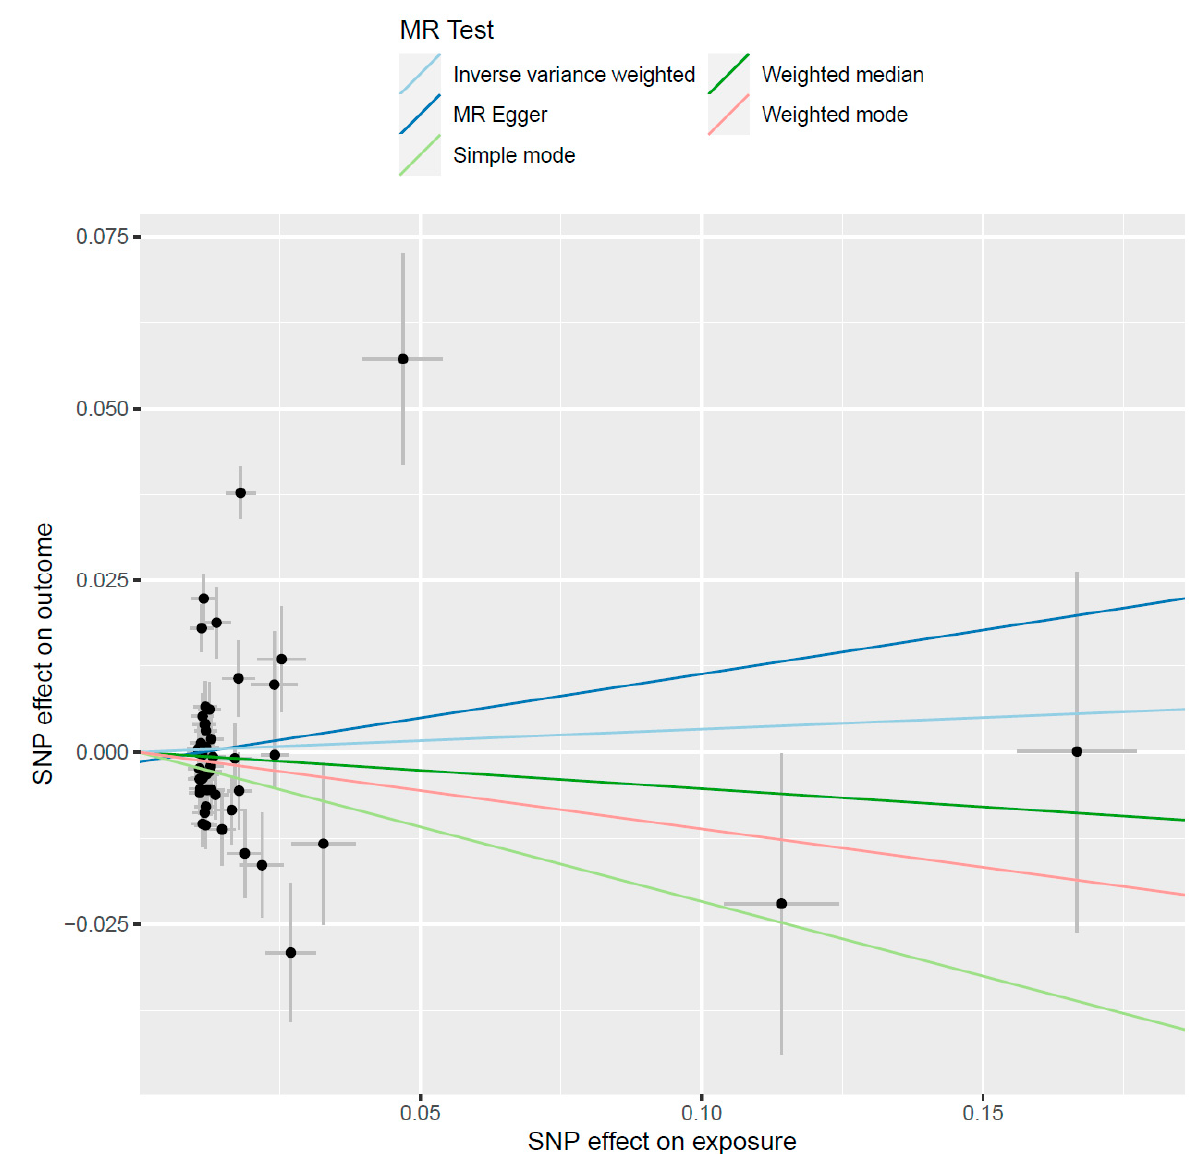
Figure 2. The causal effect of alcohol consumption on serum uric acid levels. The black circles represent the effect of individual SNPs on outcome and exposure, while the grey lines show their standard errors.